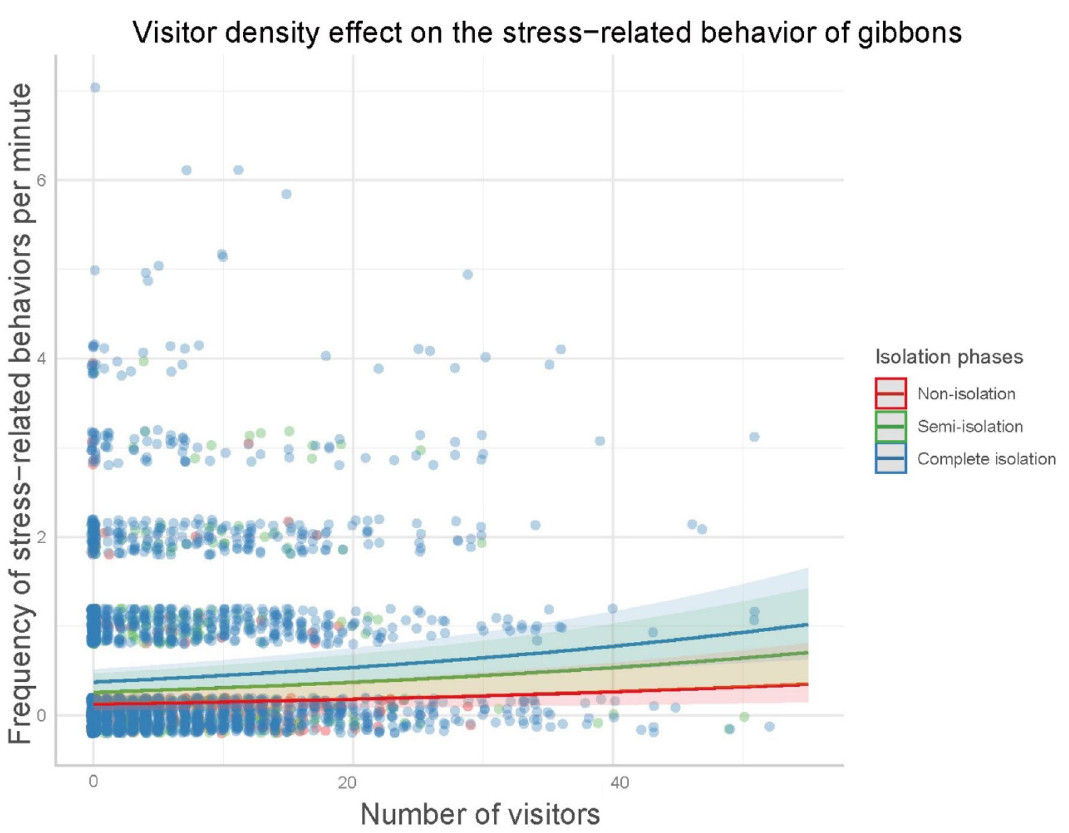
Figure 2. Effect of visitor density and social isolation (model 2a) on the stress-related behaviors of the two gibbons ( Hylobates lar and Nomascus gabriellae ). The shaded area indicates 95% confidence interval.